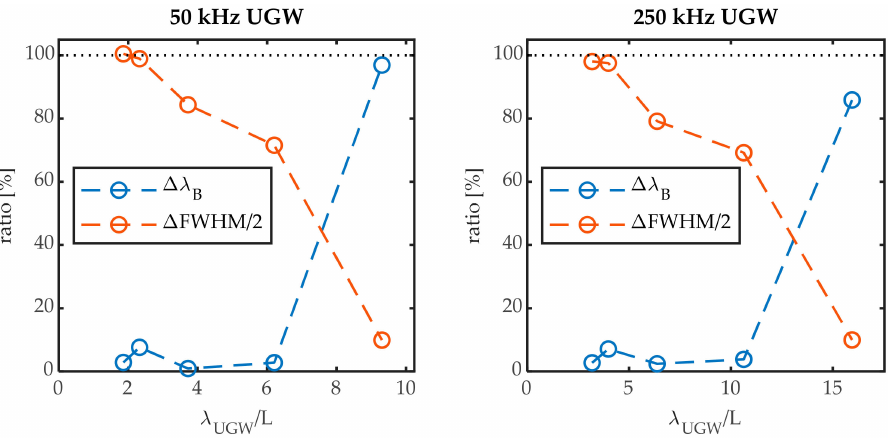
Figure 13. Ratio of the maximum amplitude of the Hilbert transform of the Bragg peak shift and Bragg peak broadening to that of the UGW measured at the steepest